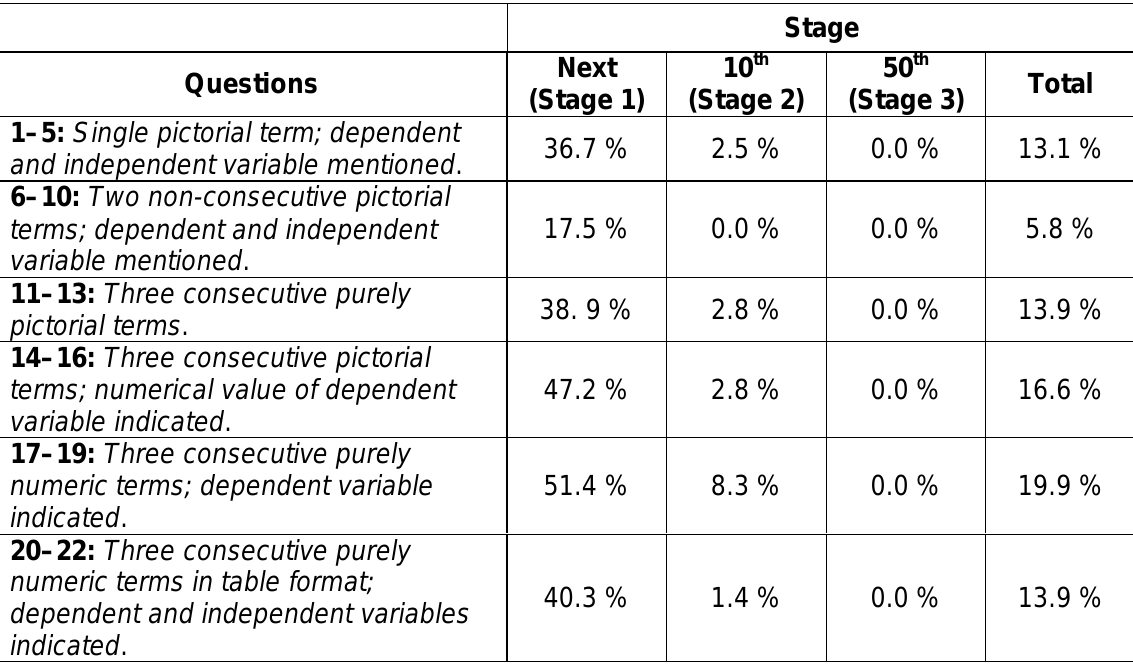
Table 1. Percentage of total responses using counting as sole